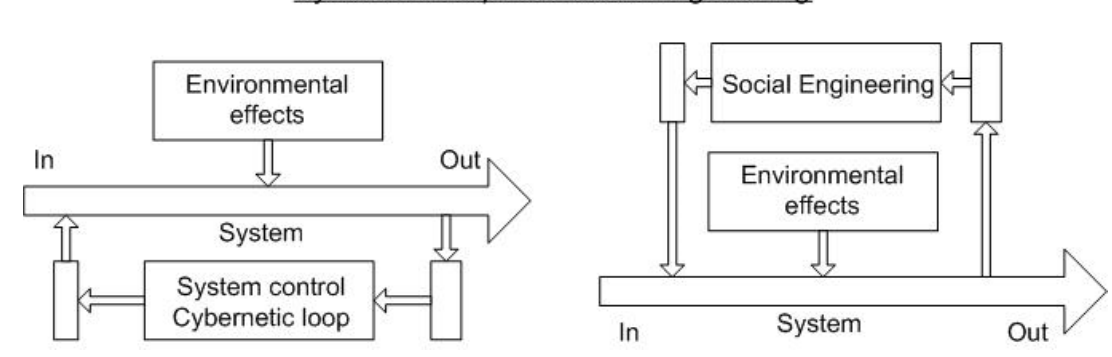
Figure 2. The parallel between the cybernetic loop and the operating scheme of social engineering.